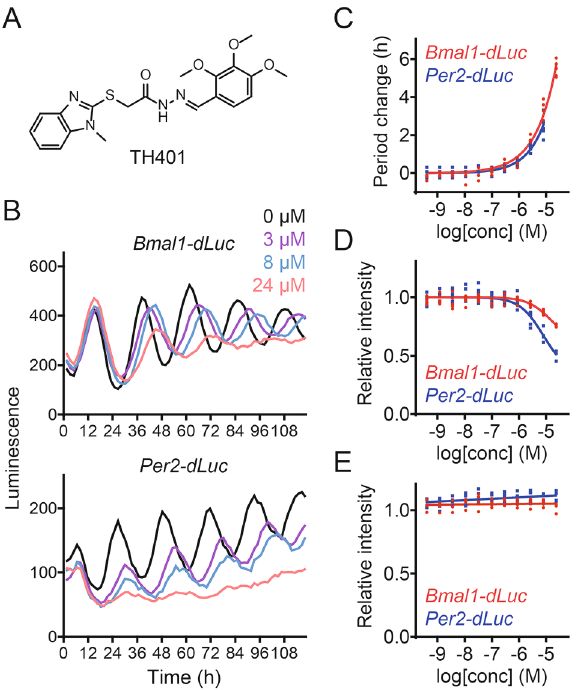
Figure1.TH401lengthenscircadianperiod. (A)ThechemicalstructureofTH401.(B-D)Effectsoncircadianrhythms in Bmal1-dLuc and Per2-dLuc U2OS cells. Luminescence rhythms in the presence of various concentrations of TH401 (B, meanof n =2) andchanges inperiod(C)and luminescence intensity(D) comparedtoadimethylsulfoxide (DMSO) control are shown ( n = 6 biologically independent samples). When arrhythmic, the period is not plotted. (E) Effect on cellviabilityin Bmal1-dLuc and Per2-dLuc U2OScells.CellularATPlevelsaftertreatmentwithvariousconcentrationsof TH401 are plotted by setting a DMSO control to 1 ( n = 4 biologically independent